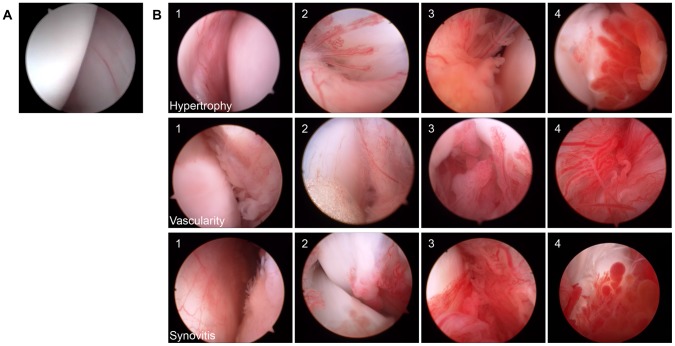
Arthroscopic appearance of stifle synovium in dogs with and without non-contact cruciate rupture.(A) Normal stifle synovium of the medial pouch in a healthy young female Hound for reference to ‘B’ [4]. Arthroscopic hypertrophy, vascularity, and synovitis scores of 0. (B) Examples of arthroscopic hypertrophy, vascularity, and synovitis scoring in various regions of the canine stifle joint. Arthroscopic scoring ranged from 1–4 [27].